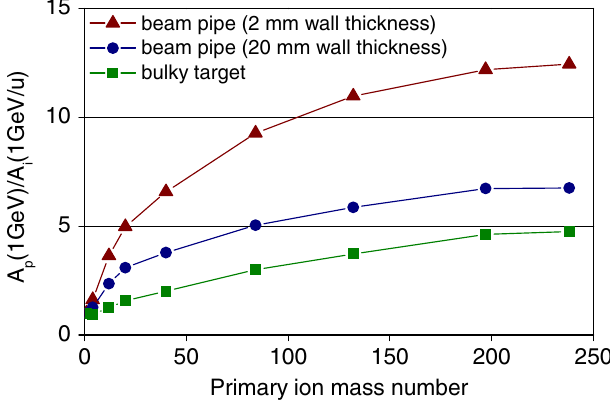
FIG. 11. (Color) Scaling factor for the beam-loss tolerance for the stainless-steel beam pipe with different wall thickness and for the bulky target. The scaling factor is represented by the ratio of the normalized activity induced by 1 GeV proton beam, ð 1 GeV Þ , to the normalized activity induced by 1 GeV = u A p ð 1 GeV = u Þ . The activities were calcu- ion beam of interest, A i lated by FLUKA at the end of irradiation. The relative standard uncertainty of the presented data is less than